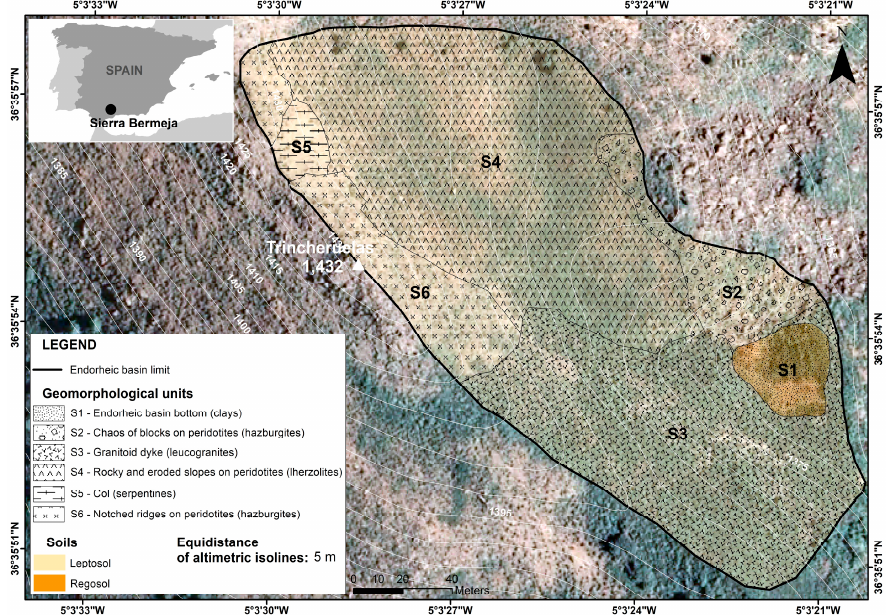
Figure 1. Location of Sierra Bermeja in southern Spain (top left) and of the geomorphological units and soils (S1–S6) sampled in the area.